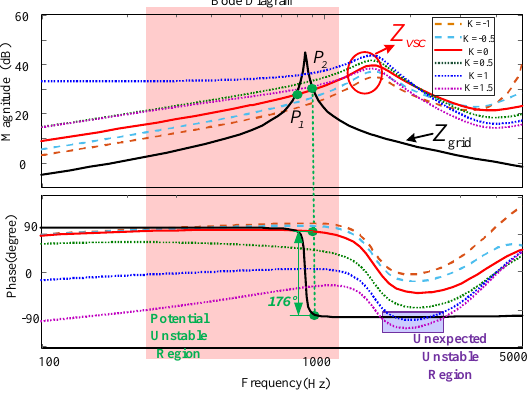
Figure 8. Reshaped impedance of VSC when different voltage feedforward coefficients are applied.